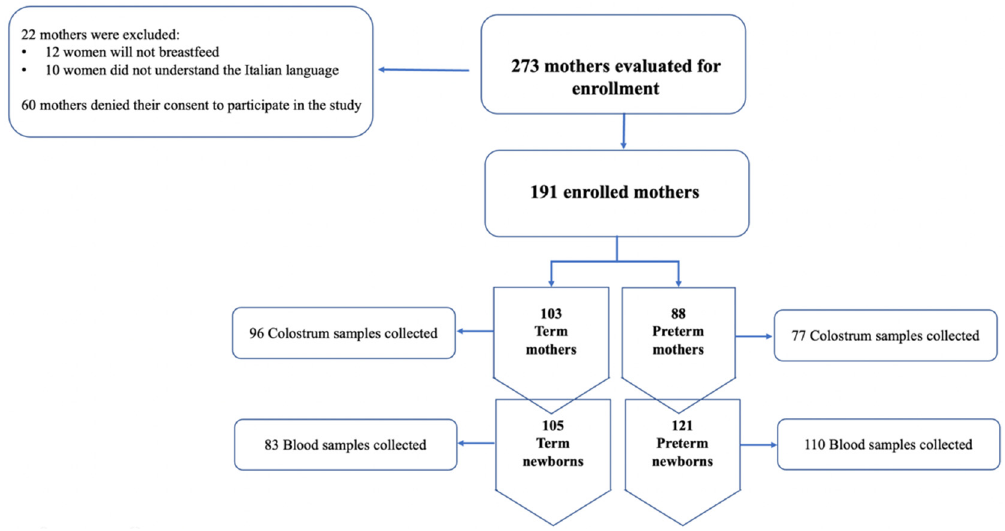
Figure 1. Flow-chart of the study .